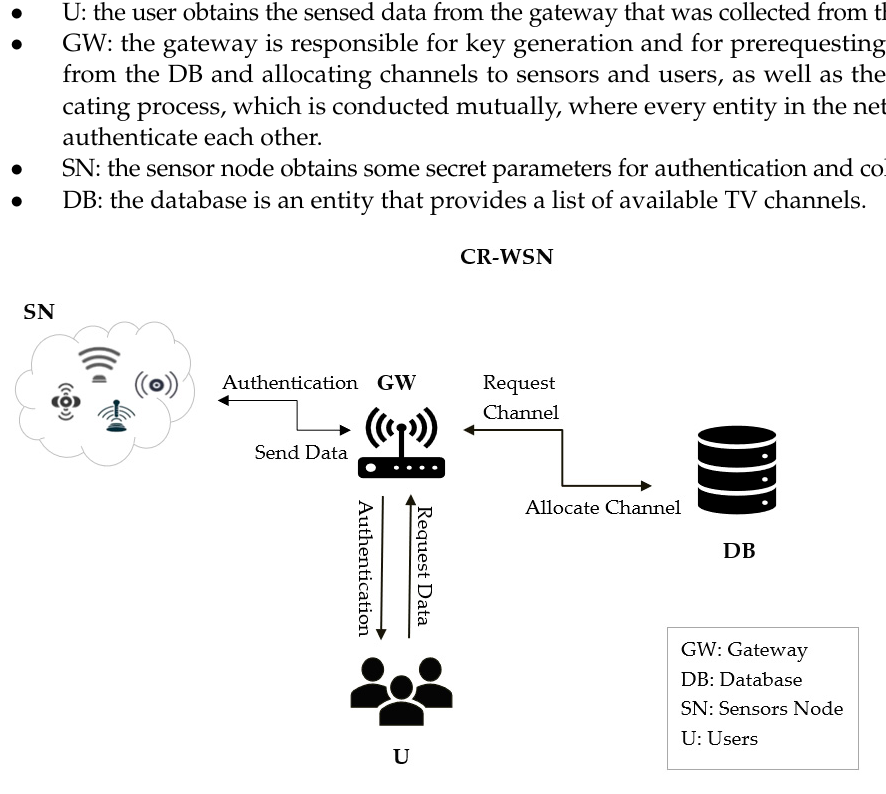
Figure 2. The framework of the proposed lightweight authentication MAC protocol for CR-WSNs.